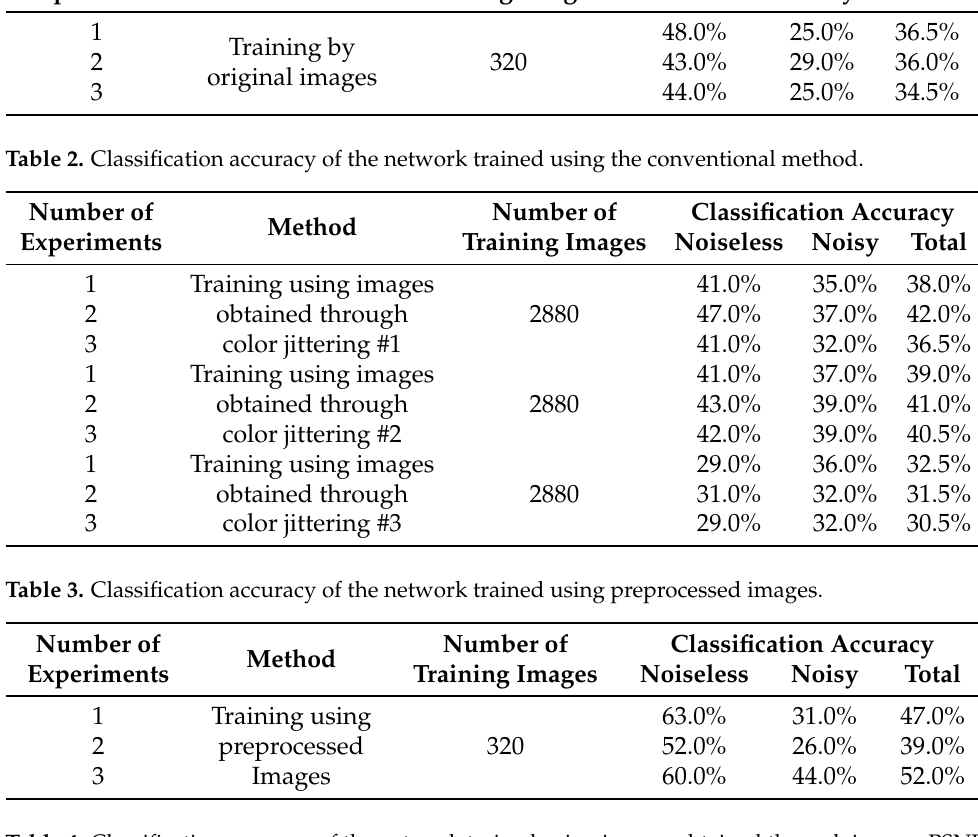
Table 4. Classification accuracy of the network trained using images obtained through inverse PSNR with RGB color space and